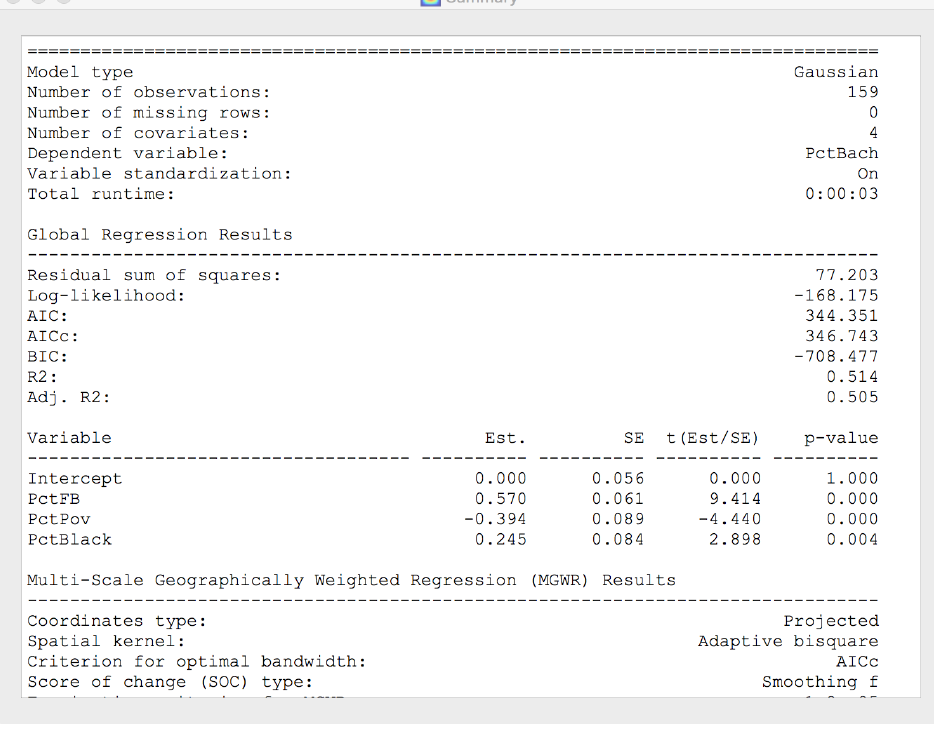
Figure 18. Summary of MGWR calibration using graphical user interface that includes global and local model